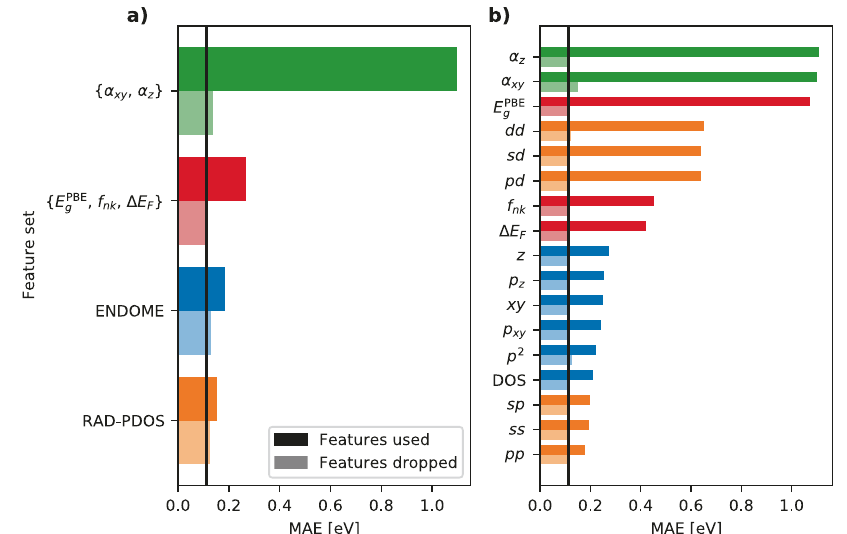
Fig. 8 Feature analysis of ML model. Solid bars refer to an ML model using only the speci fi c features while the shaded bars are for an ML model without these features. a High-level feature group. b Low-level feature